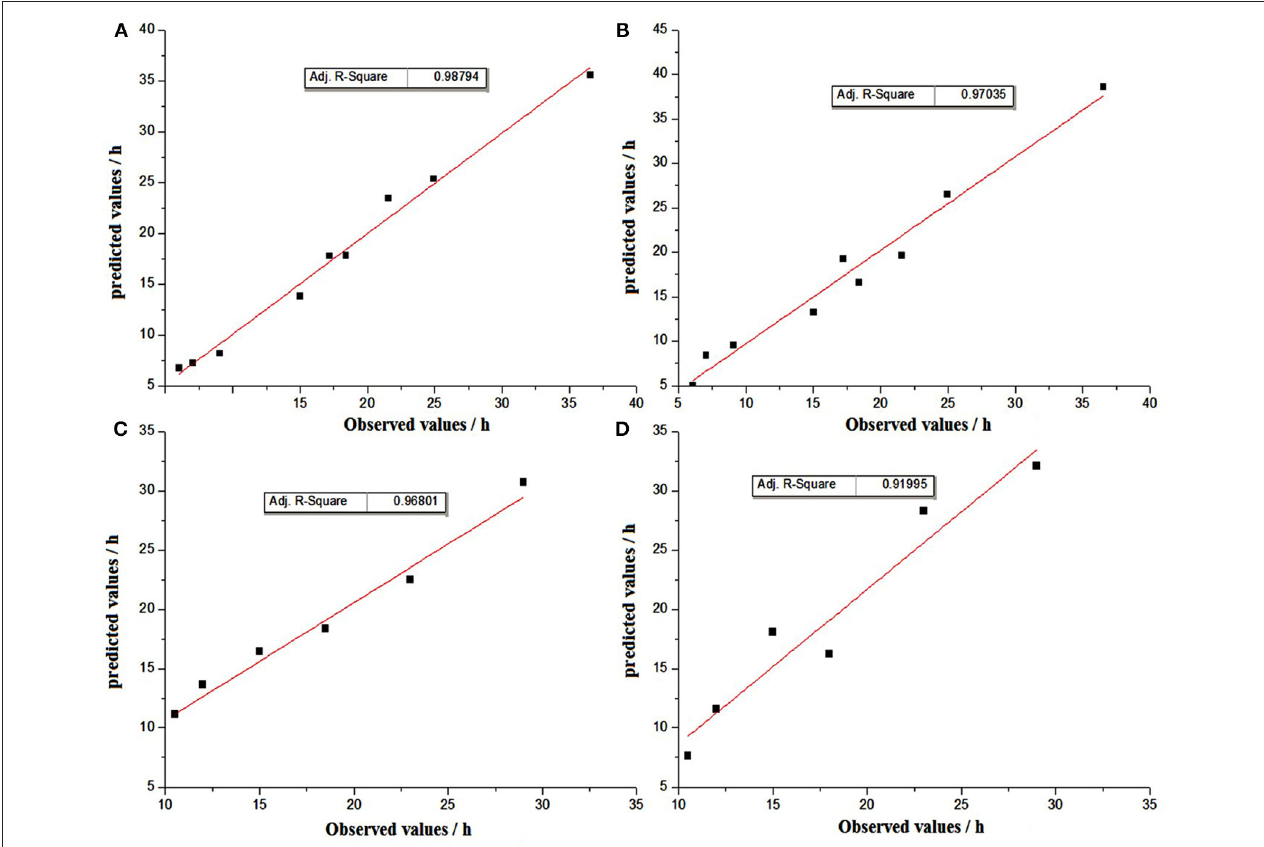
FIGURE 5 | Graphical comparisons beteween observed and predicted TTD values by the method of linear polynomial regression for internal validation (A) and external validation (C) ; by the method of threshold for internal validation (B) and external validation (D) .